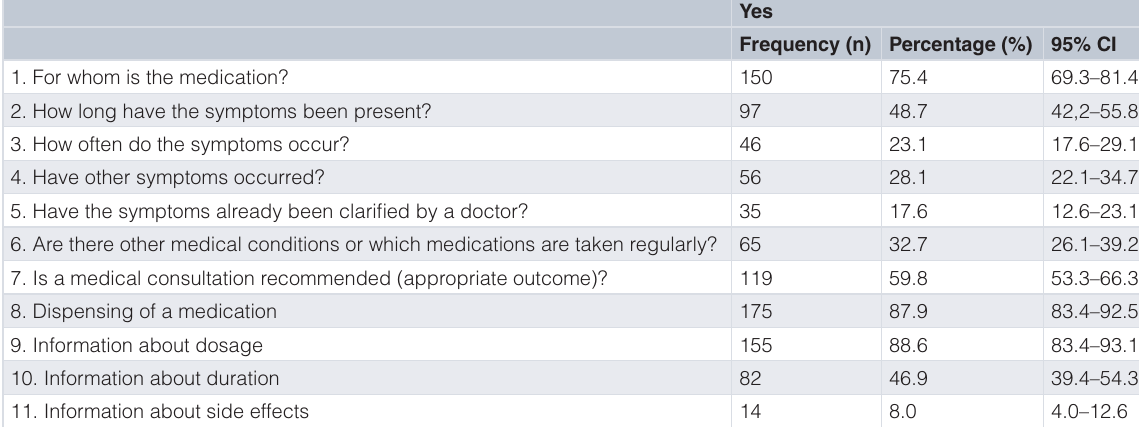
Table 4. Assessment items on the evaluation form (n =